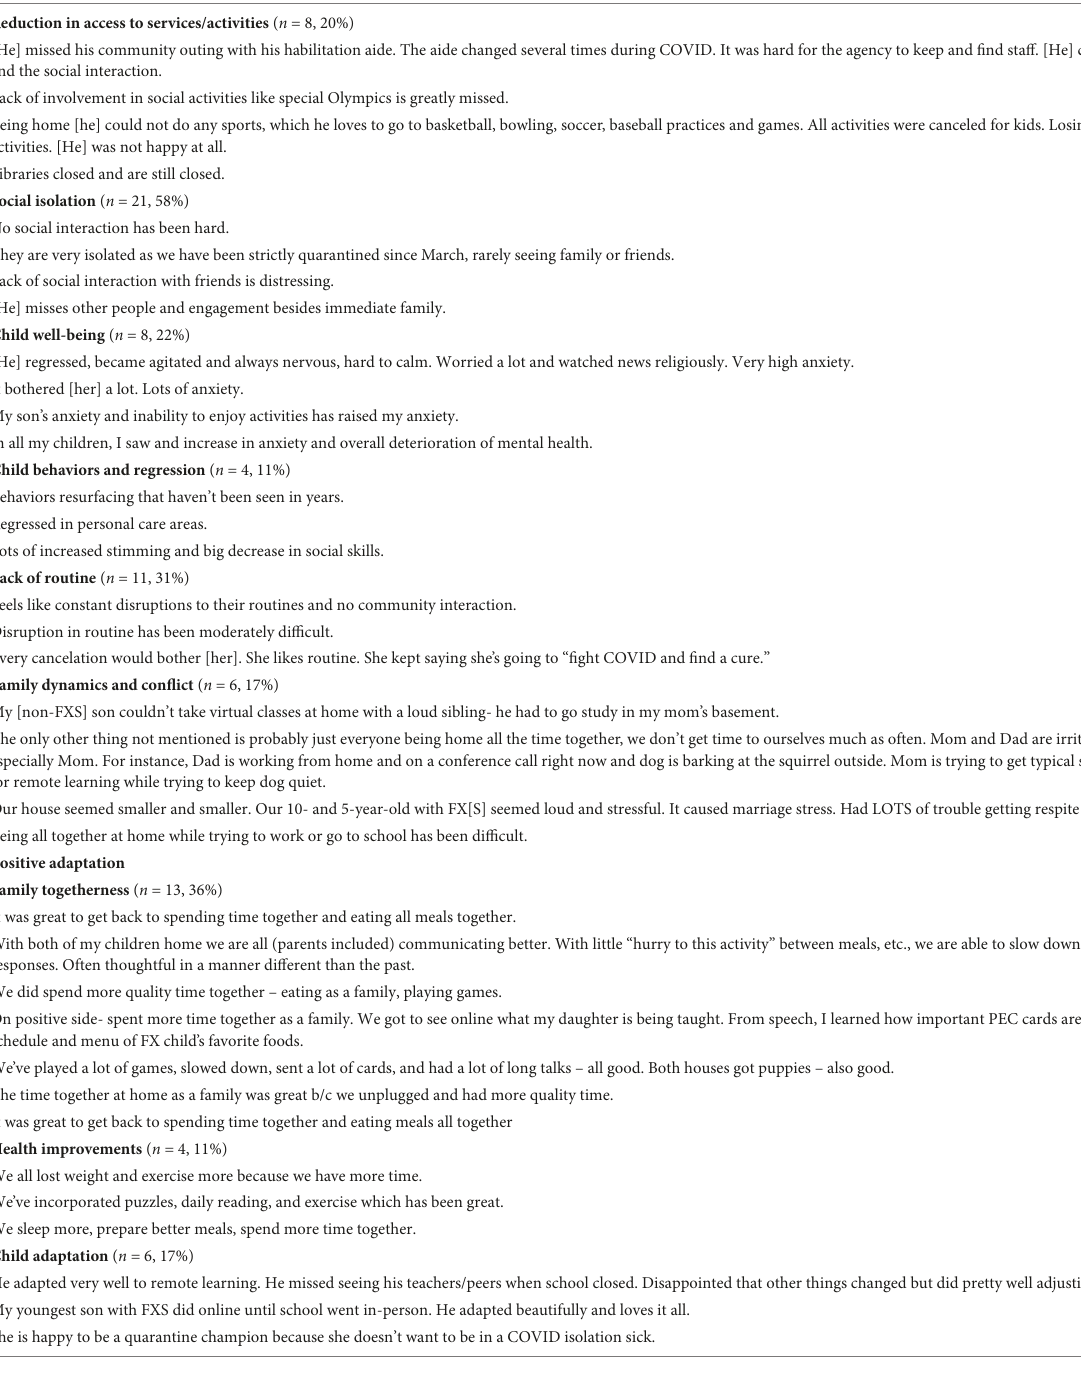
TABLE 2 Examples of COVID-19 associated difficulties and positive adaptations reported by mothers. Sources of stress/negative